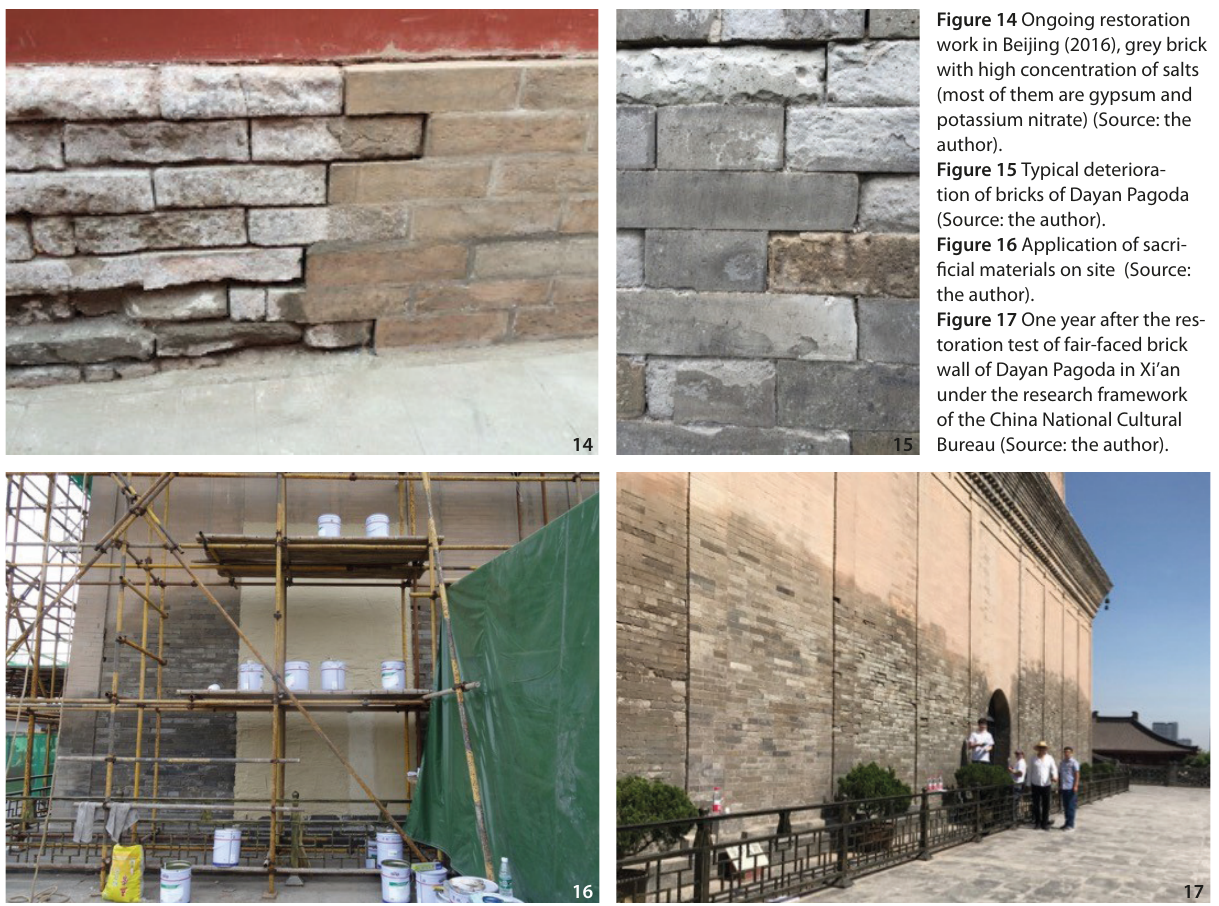
Figure 14 Ongoing restoration work in Beijing (2016), grey brick with high concentration of salts (most of them are gypsum and potassium nitrate) (Source: the author). Figure 15 Typical deteriora- tion of bricks of Dayan Pagoda (Source: the author). Figure 16 Application of sacri- ficial materials on site (Source: the author). Figure 17 One year after the res- toration test of fair-faced brick wall of Dayan Pagoda in Xi’an under the research framework of the China National Cultural Bureau (Source: the